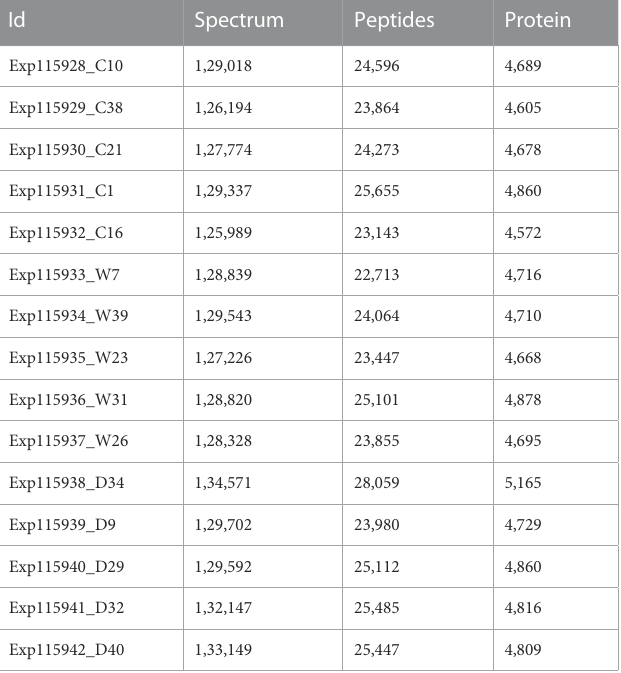
TABLE 1 Number of spectra, identi fi ed peptide segments and proteins by each sample.